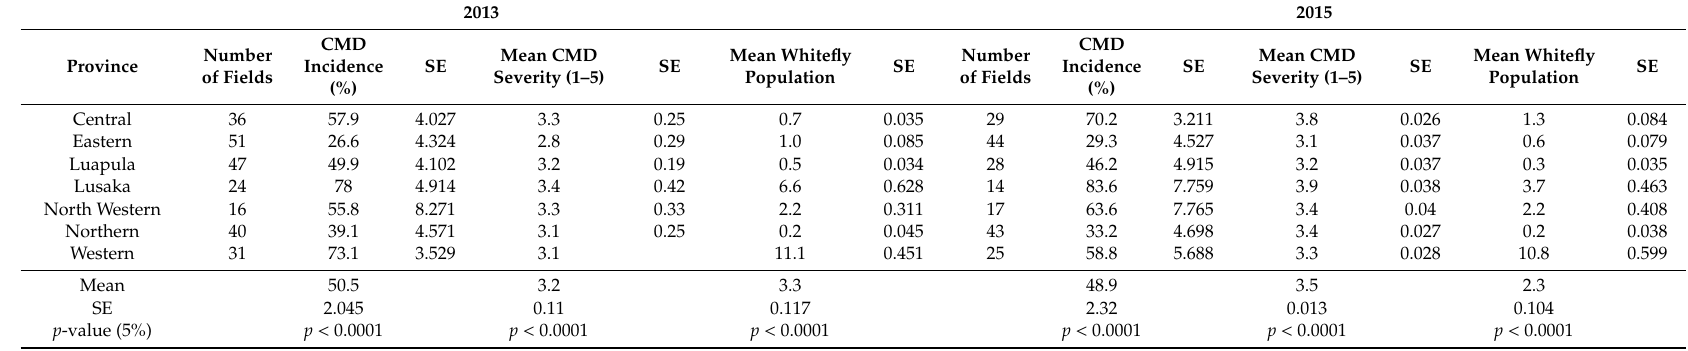
Table 4. Cassava mosaic disease (CMD) incidence, disease severity and whitefly population on cassava in seven provinces of Zambia in (a) 2013 and (b) 2015. 2013 2015